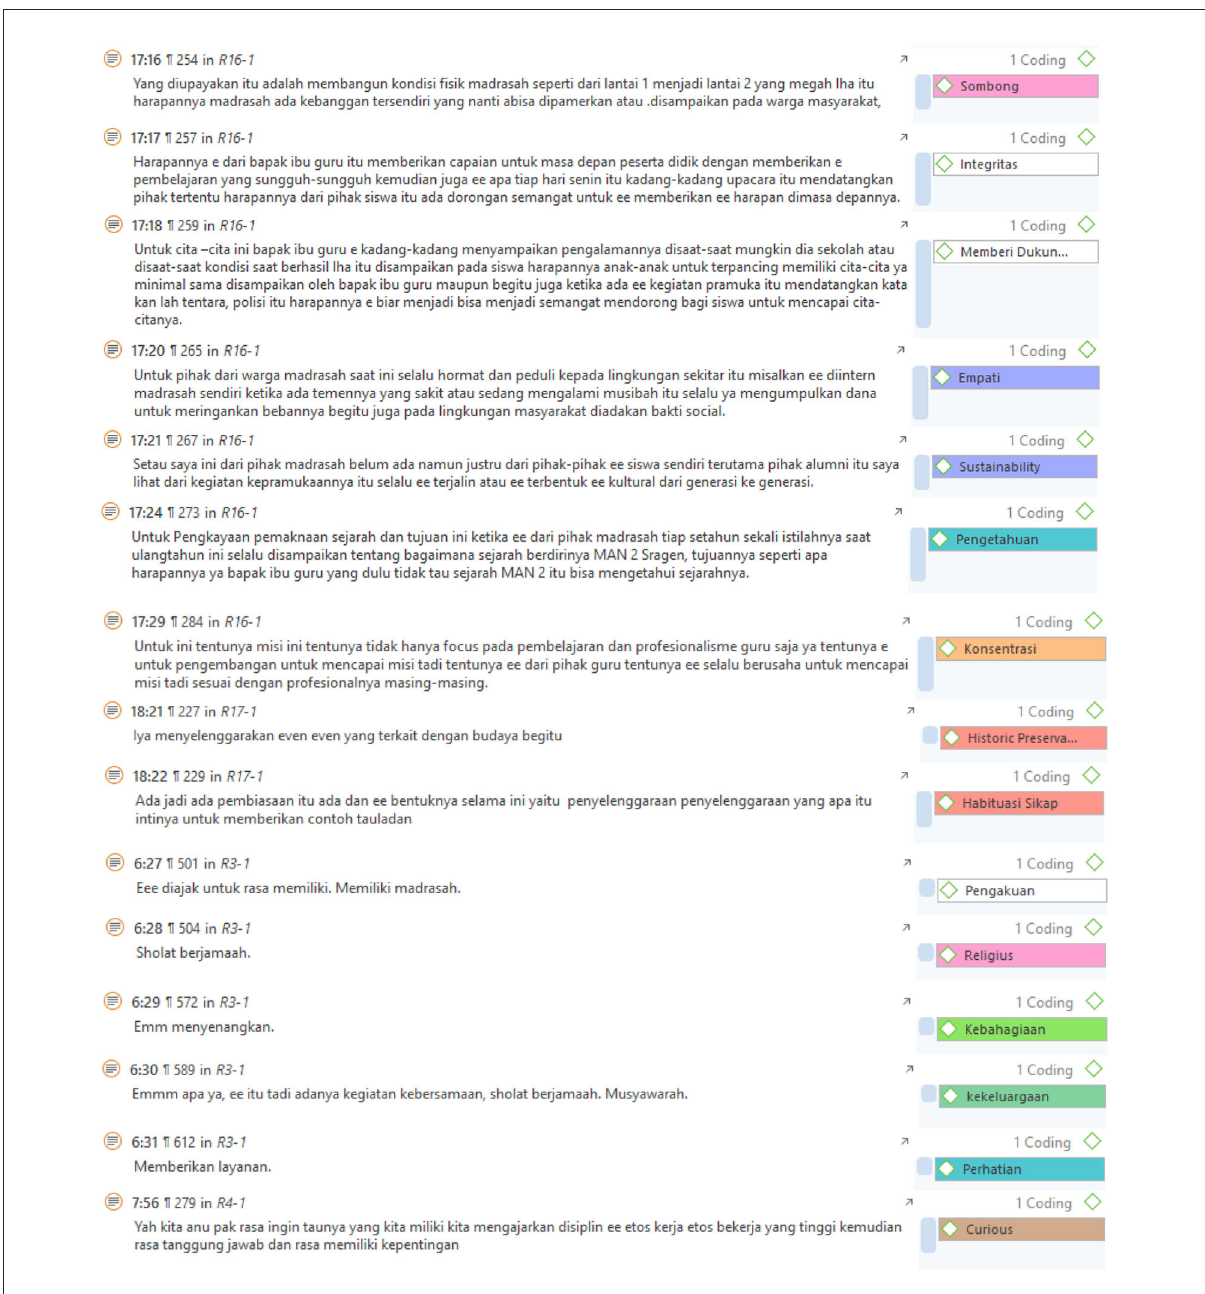
FIGURE5 Values on the principal’s